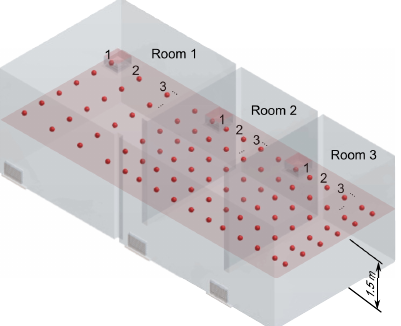
Figure 7. Horizontal plane crossing the rooms’ physical domains. Dozens of evenly spaced sampling points are placed over each compartment to probe data at the height of 1.5m from the floor, reference point where the velocity field must comply with the Brazilian technical regulations.